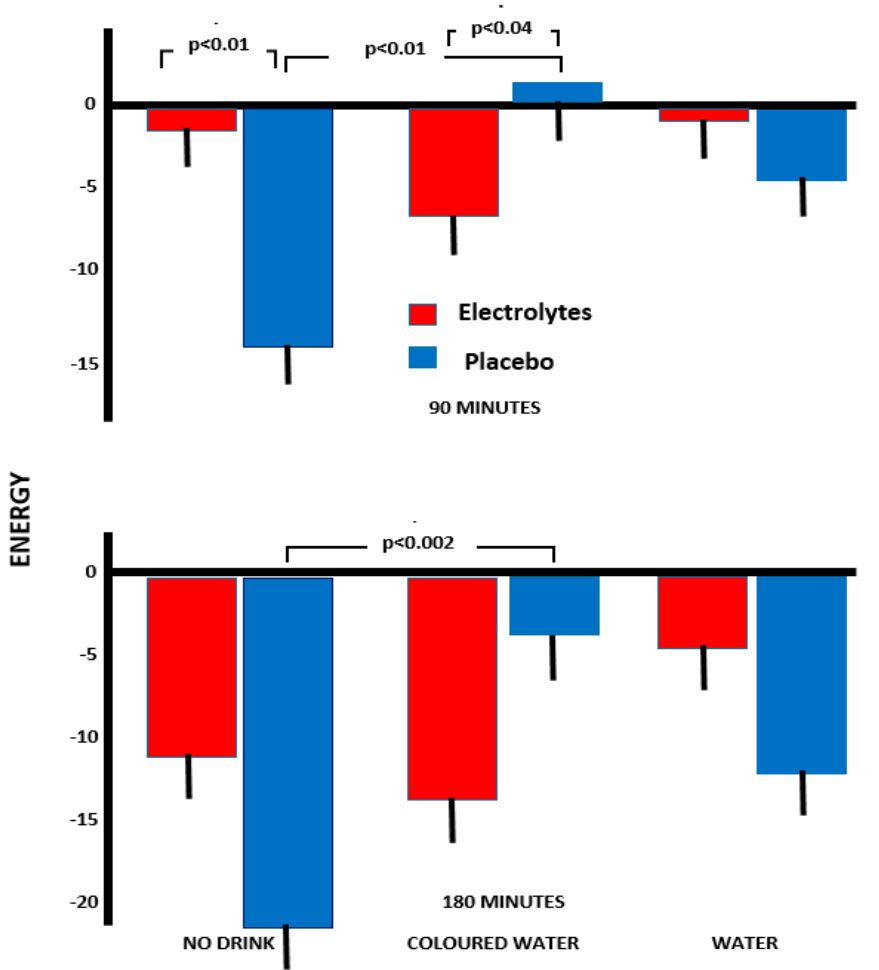
Figure 3. The influence of various drinks on changes over the morning in energy. The data are means +/ − standard errors with a minus figure indicating decreased energy.